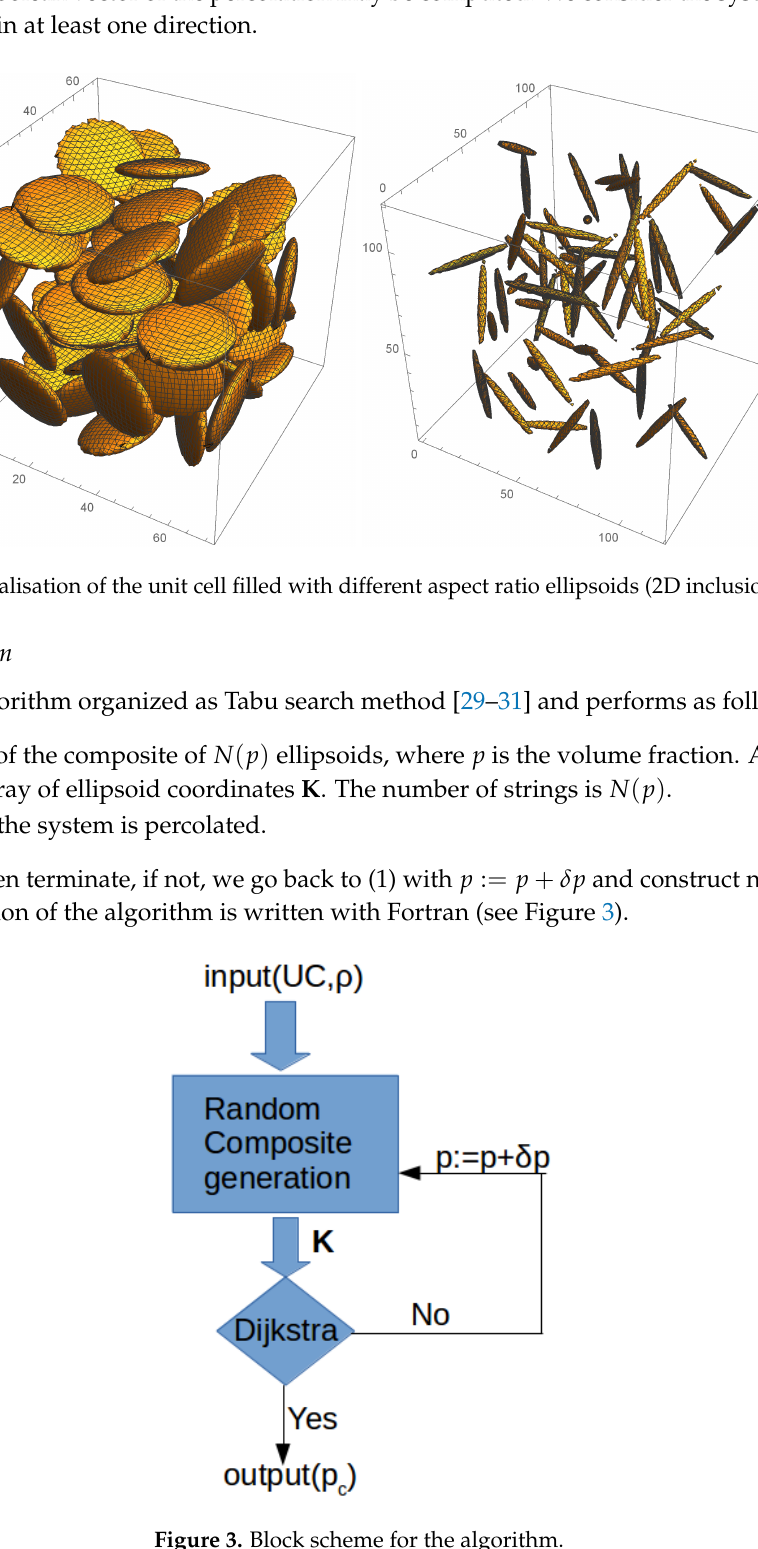
Figure 3. Block scheme for the